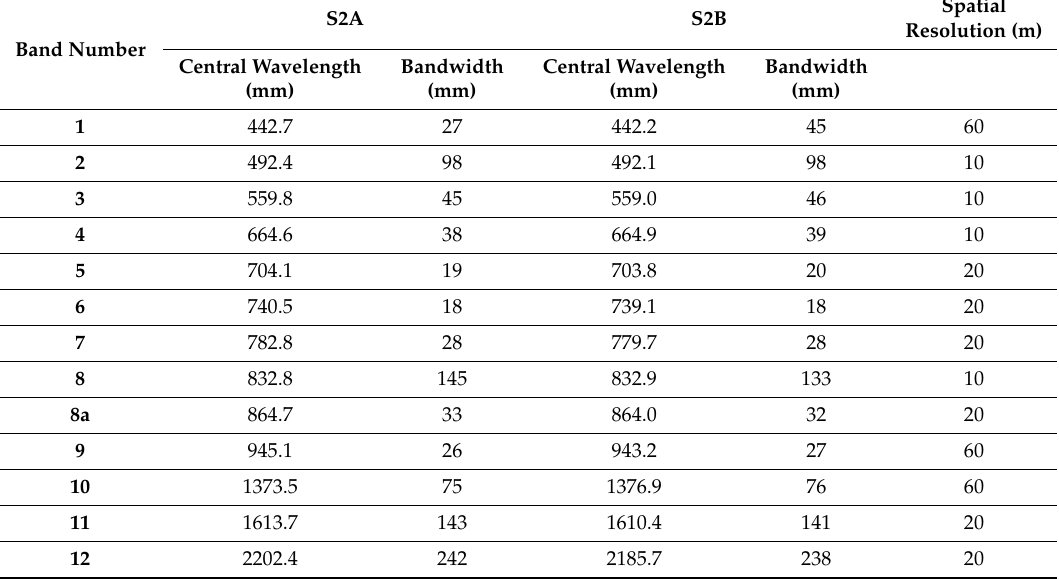
Table 1. Wavelengths, bandwidths and spatial resolutions of the 13 bands of the multi-spectral imager (MSI)